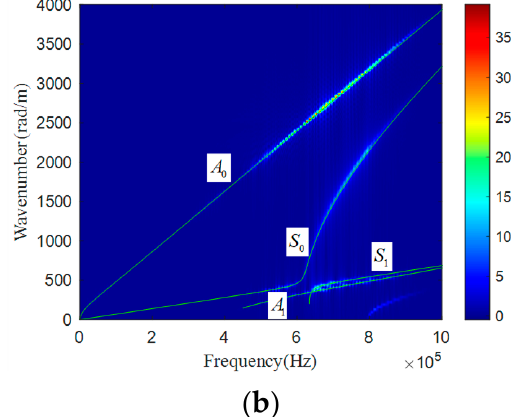
Figure 11. ( a ) Dispersion curve of GW along the fiber direction in UD, and ( b ) contour of frequency-wave number spectrogram superposed with the dispersion curve of GW based on the reconstructed C 12 .